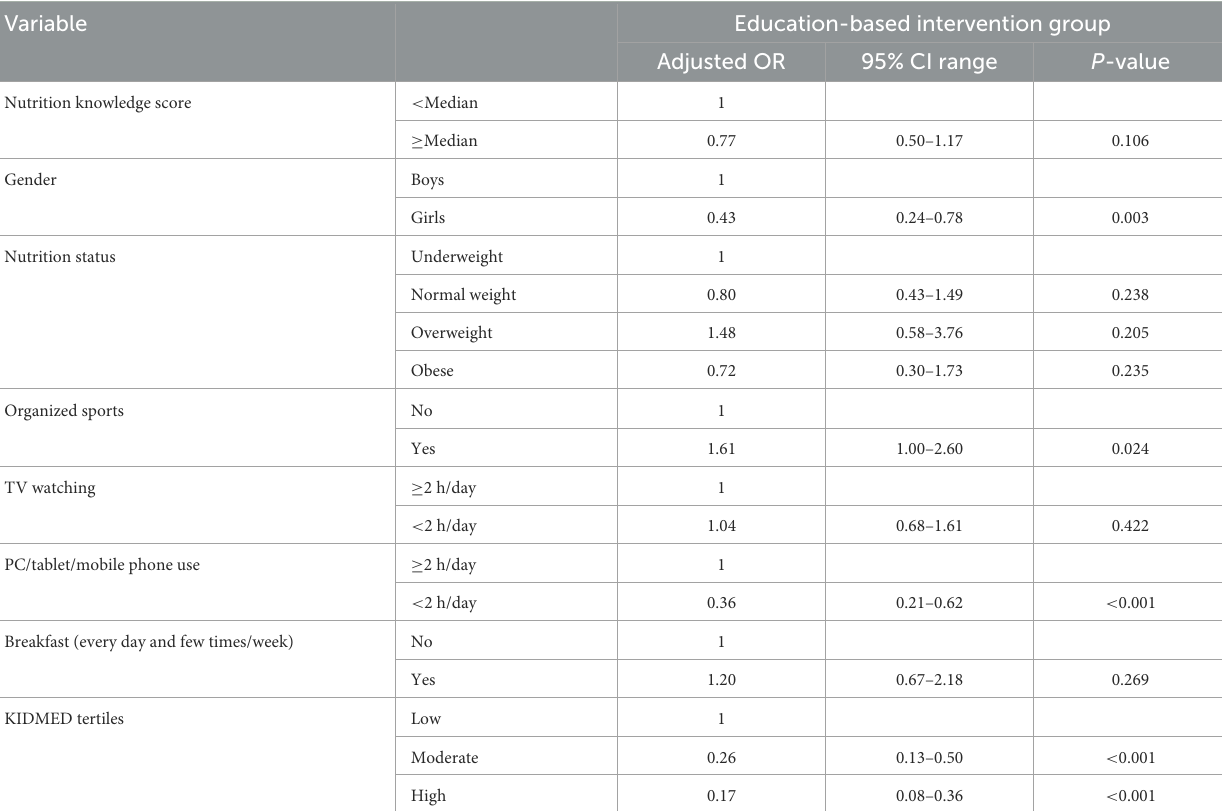
TABLE 2 The adjusted odds ratios (95% CI) for nutrition knowledge, gender, nutrition status, active and sedentary lifestyle, and diet quality in the intervention group in the relation to the control group as referent at the study baseline. Variable